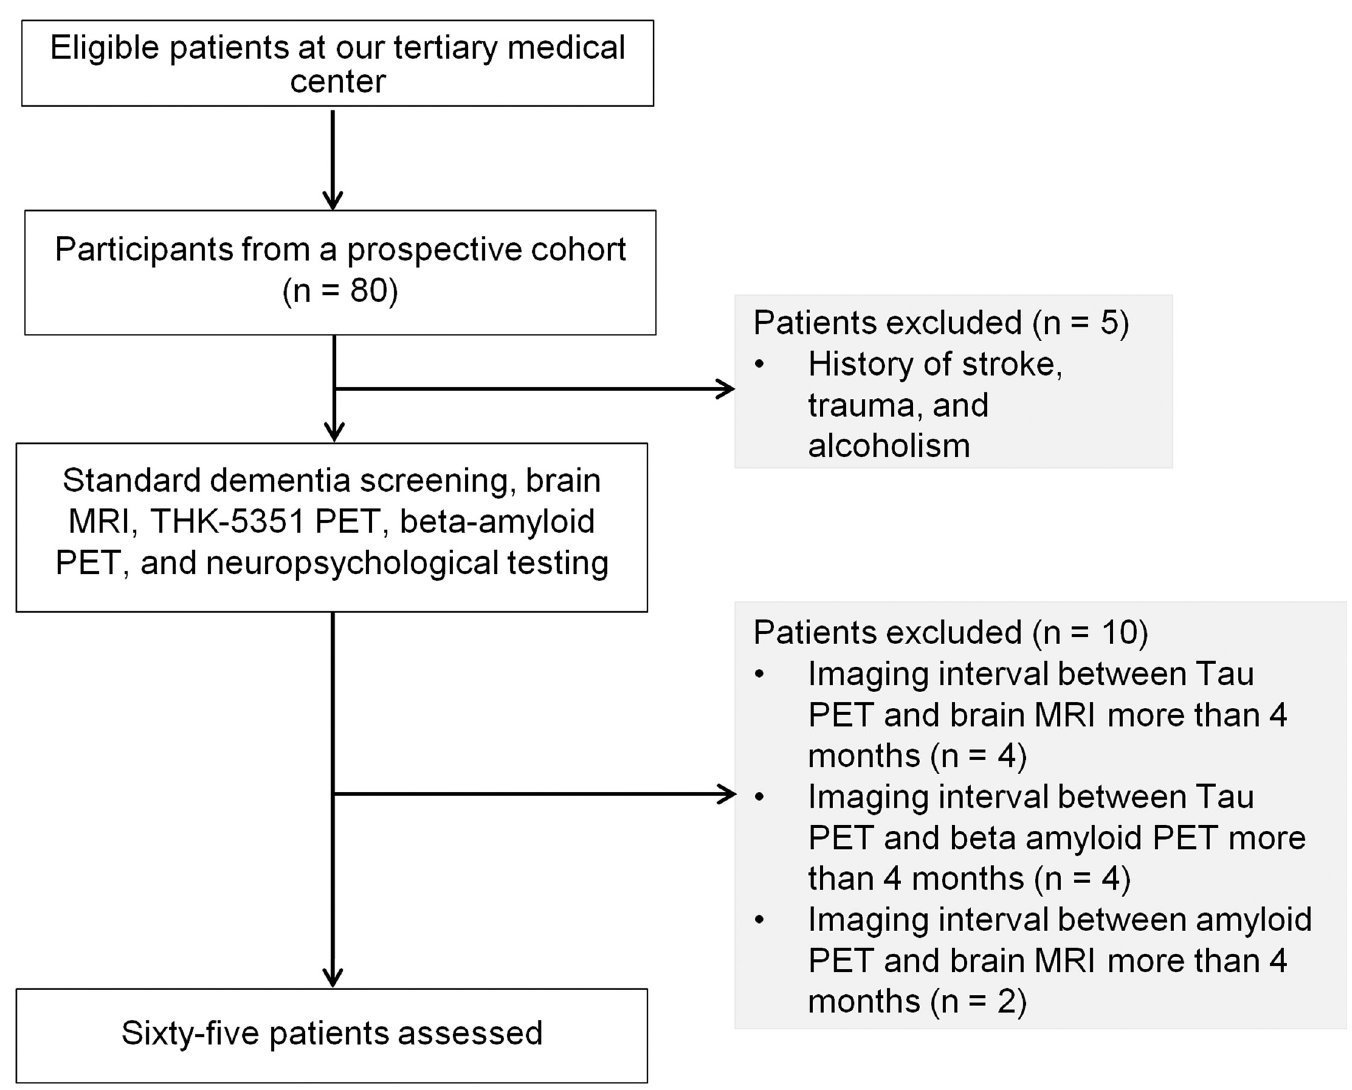
Fig 1. Flow diagram of the participant inclusion process of the